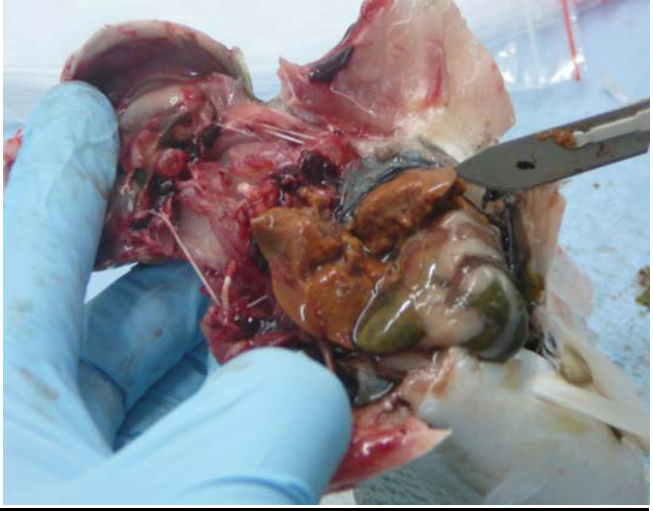
Figure 4. Removal of mullet liver, study lake capture 7 September 2009. These livers were extremely friable; some broke apart when manipulated. Care was needed in order to remove livers en bloc .